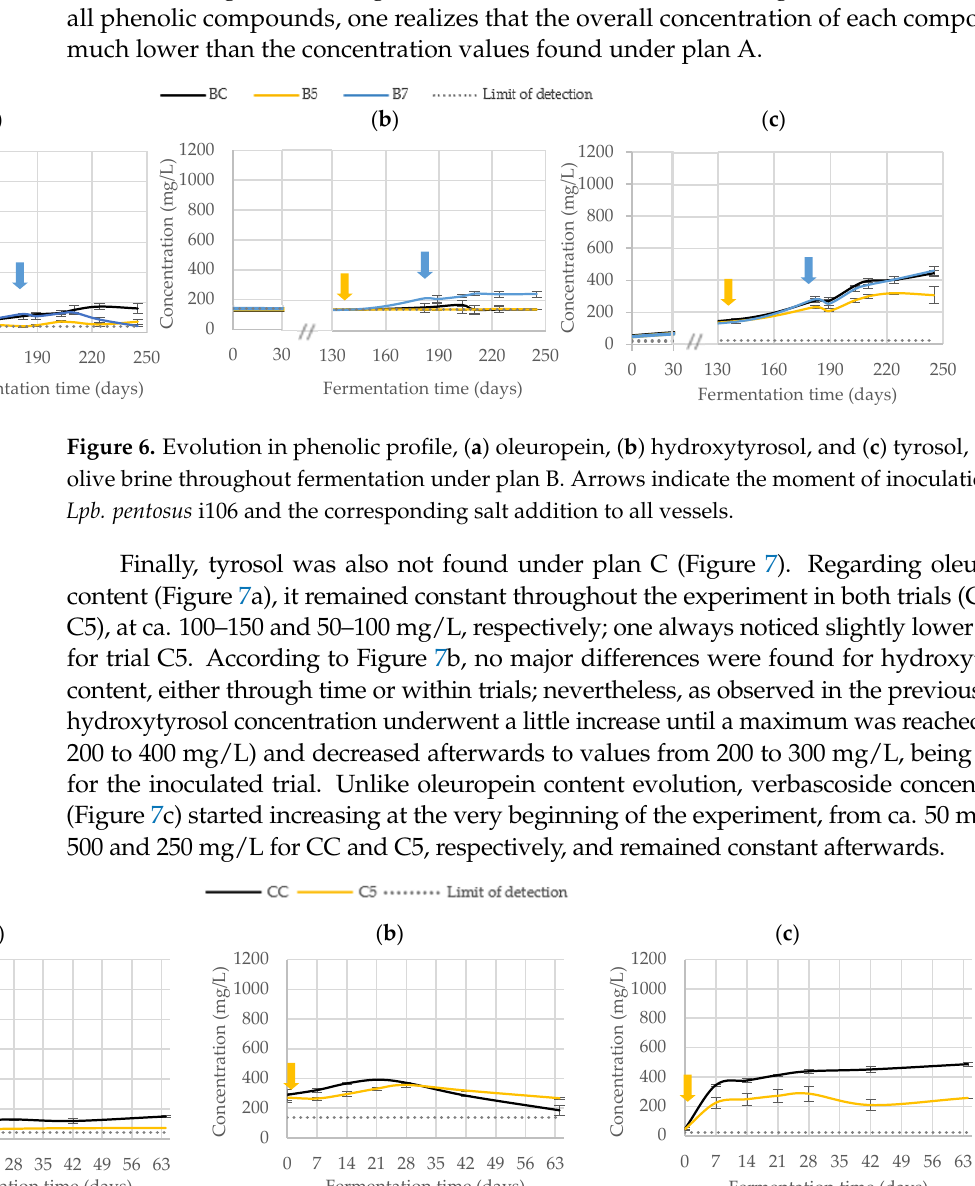
Figure 7. Evolution in phenolic profile, ( a ) oleuropein, ( b ) hydroxytyrosol, and ( c ) tyrosol, of table olive brine throughout fermentation under plan C. Arrows indicate the moment of inoculation with Lpb. pentosus i106 and the corresponding salt addition to all vessels.